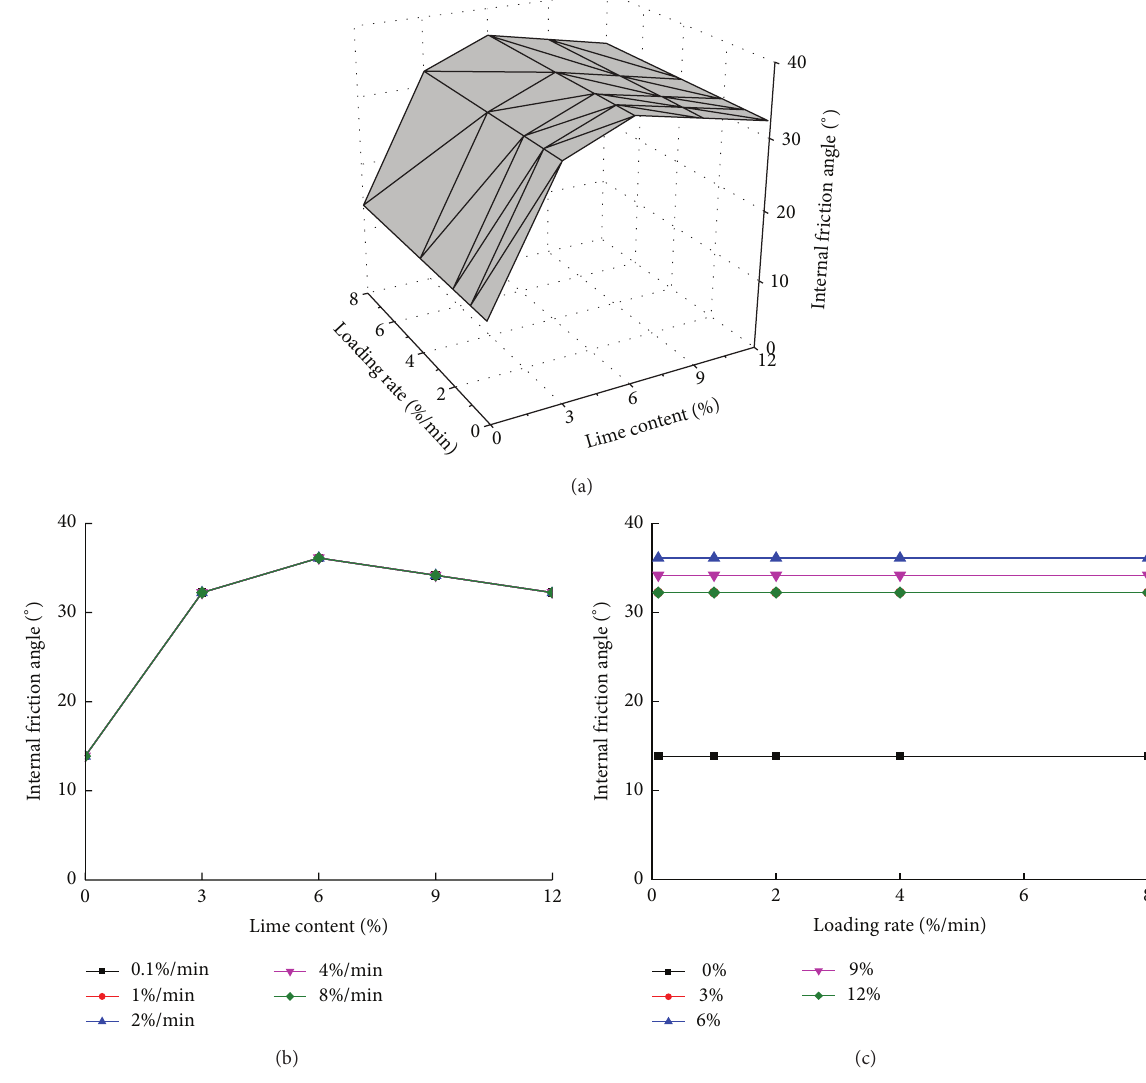
Figure 7: Relation between internal friction angle and lime content and loading rate of (a) internal friction angle three-dimensional curved surface (21 days), (b) internal friction angle lime content (21 days), and (c) internal friction angle loading rate (21